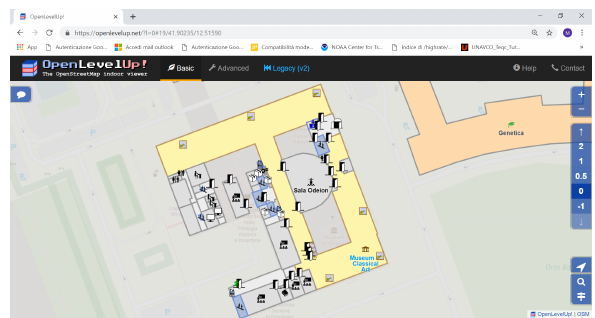
Figure 6. Open Level Up indoor map of the faculty of Letters and Philosophy